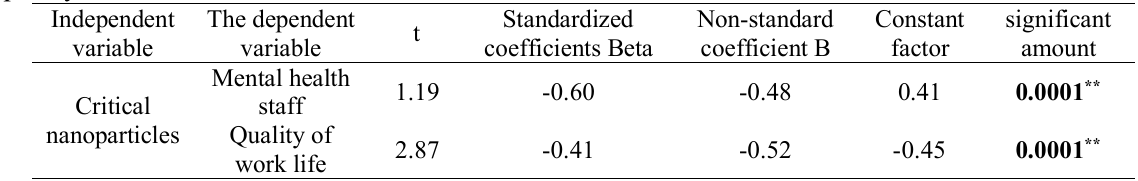
Table 2. nanoparticles are critical factors to determine the impact on their mental health and quality of work life